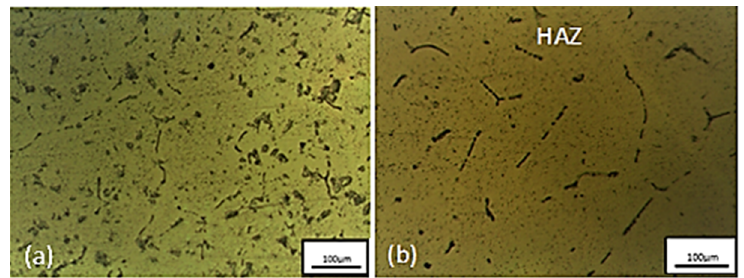
Figure 25. Microscopy image of, ( a ) parent material and ( b ) HAZ using TTH tool at 1200 rpm, 25 mm/min.